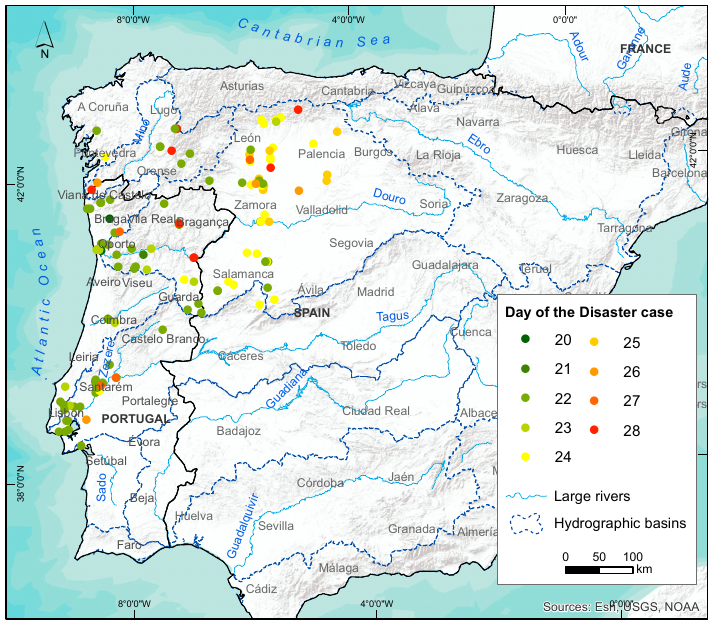
Figure 7. DISASTER cases of the December 1909 event per day.